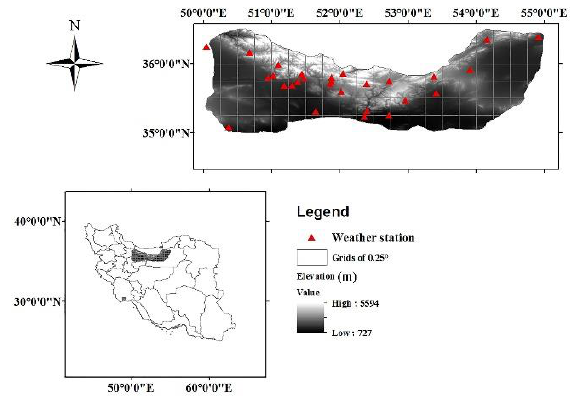
Figure 1. Location, rain gauge stations, topographic characteristics and elevation (m) of the study area Four statistical criteria of mean differences (Bias), mean absolute error (MAE), root mean square error (RMSE) and correlation coefficient (R) were employed to assess the accuracy of satellite precipitation data. Table 1 represents a list of statistical criteria used in this study. According to this table, PSi denotes the amount of satellite precipitation in the i-th time step, POi denotes the observed precipitation in the i-th step, N is the number of precipitation data, PS denotes the average amount of satellite precipitation per pixel and PO denotes the average precipitation in rain gauge stations. It is obvious that the high PCC content and the low values of RMSE and MAE show the high accuracy of estimates. Also, negative and positive values of Bias represent a satellite data,